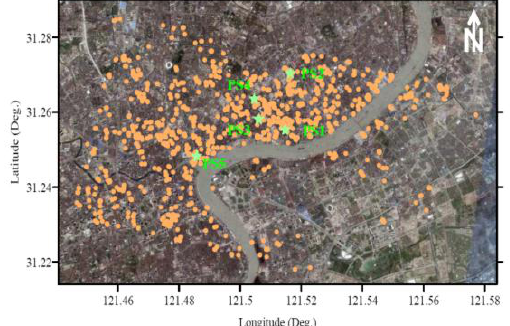
Figure 5. PSs superimposed onto an optical orthoimage